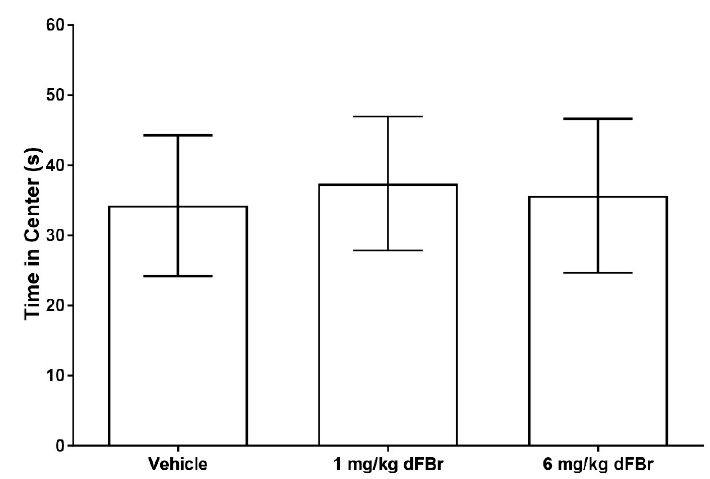
Figure 5. Desformylflustrabromine does not cause a significant change in the time spent in the center of the arena by CD-1 mice in the open field exploration test. The time spent in the center is expressed in seconds as mean ( ± S.D.). Statistical significance was considered as p < 0.05. Twelve mice were included in each treatment group ( n = 12).